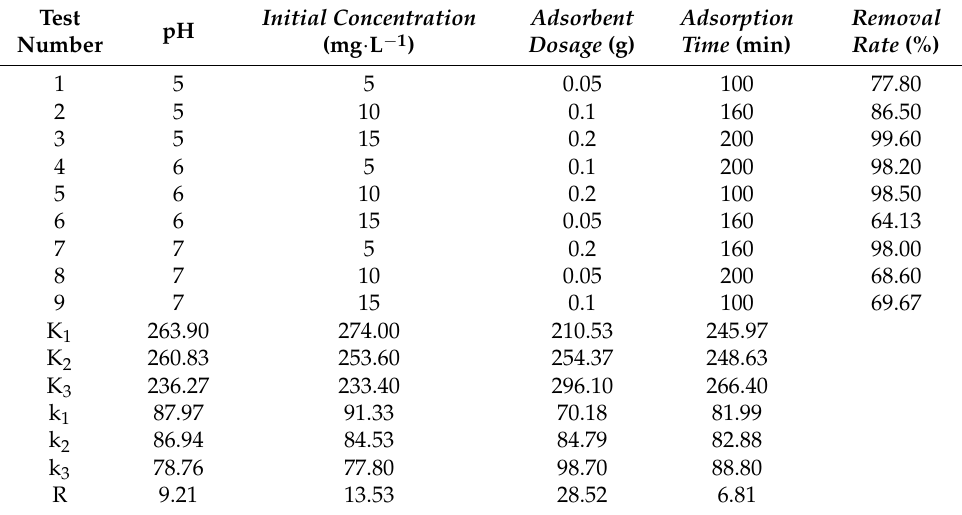
Table 1. Orthogonal experiment results and range analysis.